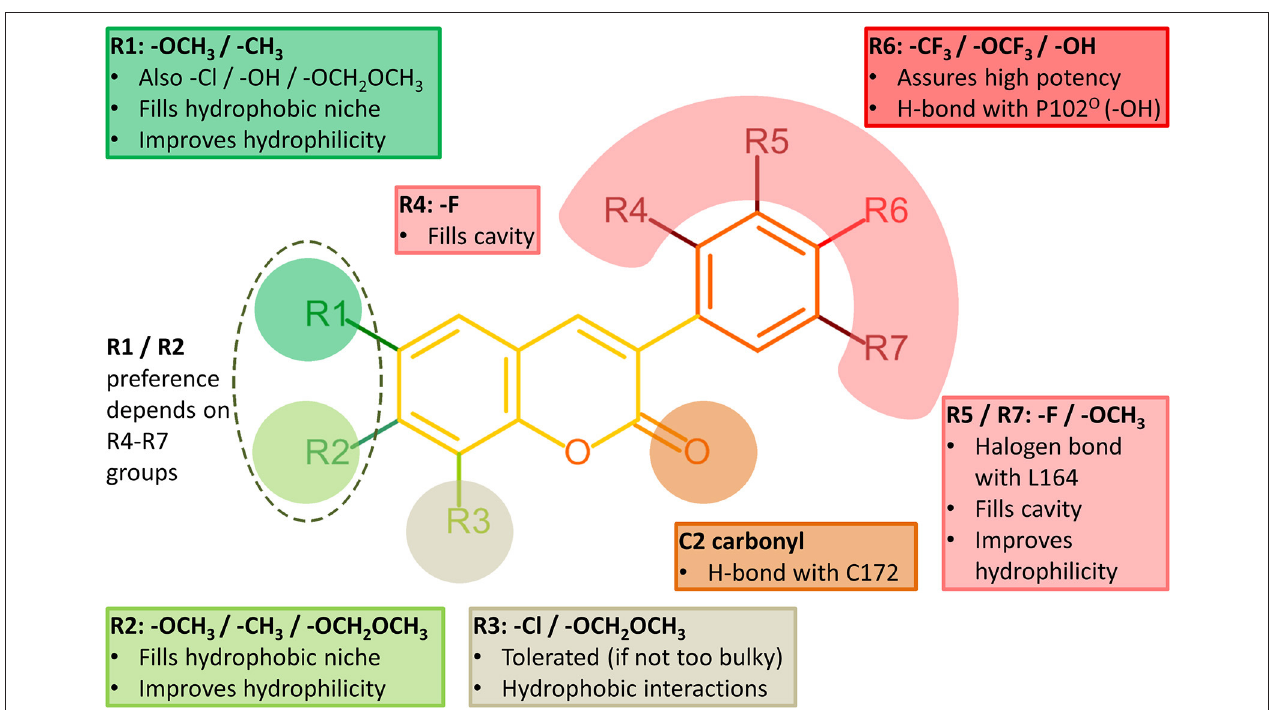
FIGURE 4 | Structure-activity relationship (SAR) analysis of the 3-phenylcoumarin derivatives.